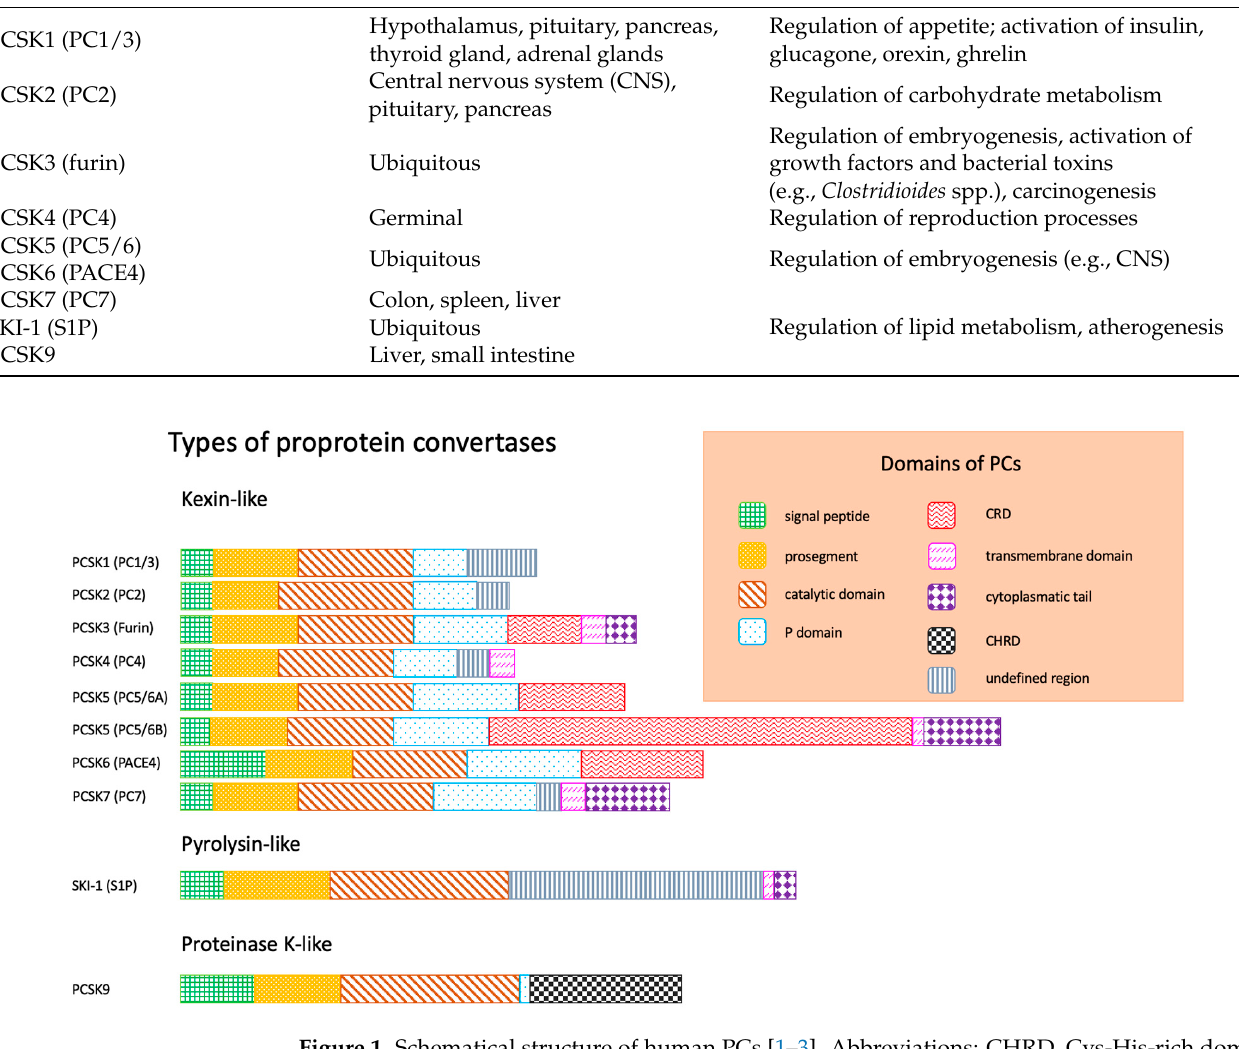
Figure 1. Schematical structure of human PCs [1–3]. Abbreviations: CHRD, Cys-His-rich domain; CRD, Cys-rich domain; PCSK1 (PC1/3), proprotein convertase subtilisin/kexin type 1 (proprotein